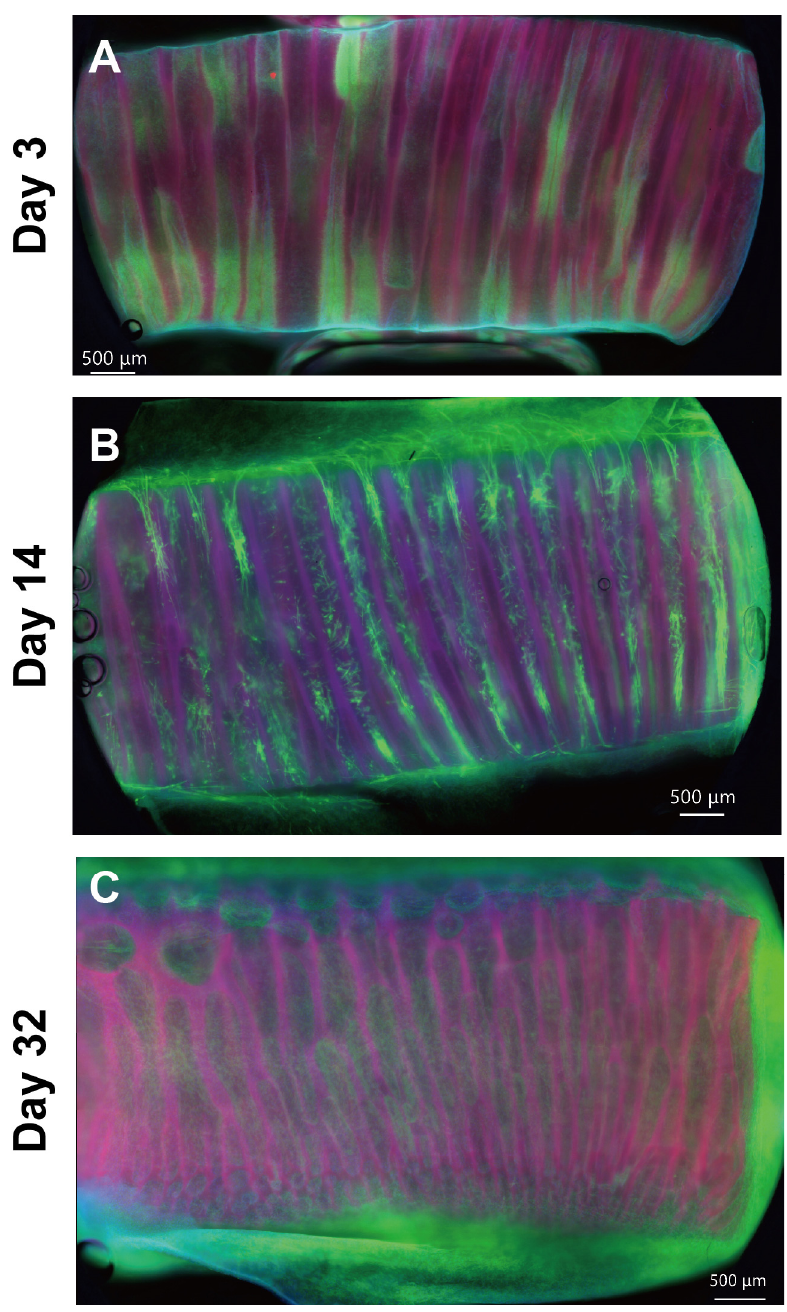
Figure 1. Whole mount fluorescence microscopy images of the EMT obtained at different culture periods (( A ) 3 days, ( B ) 14 days, and ( C ) 32 days). Nuclei, F-actin, and collagen are colored blue, green, and red, respectively.